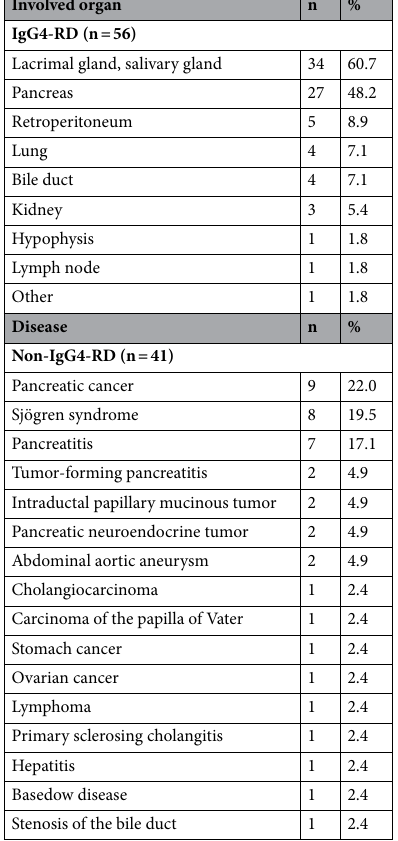
Table 2. Organs involved in the IgG4-RD group and diseases in the non-IgG4-RD group. ROC analysis was performed between 56 pre-treatment patients in the definite IgG4-RD group and 41 patients with confirmed